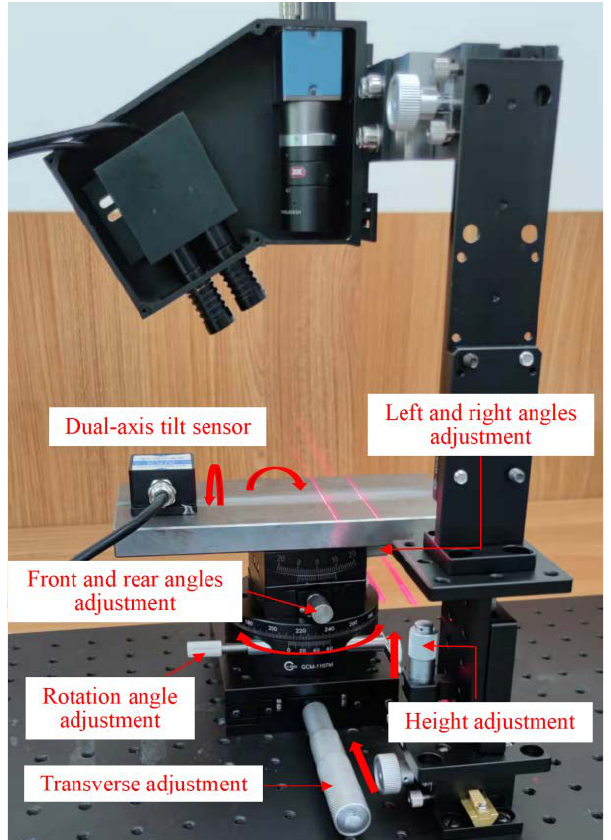
Figure 10. Parameters detection test platform based on designed vision sensor.